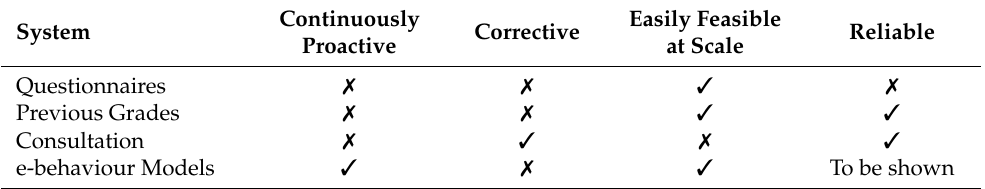
Table 1. Comparison of evaluation